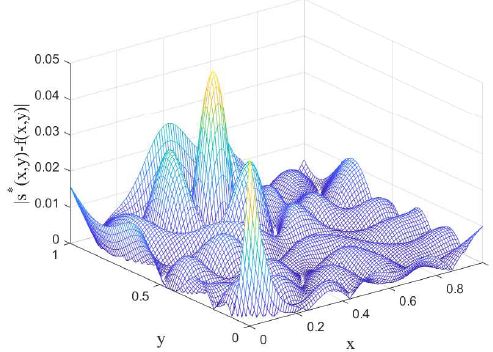
Figure 14. The error function | s ∗ ( x , y ) − f ( x , y ) | on [ 0,1 ] × [ 0,1 ]